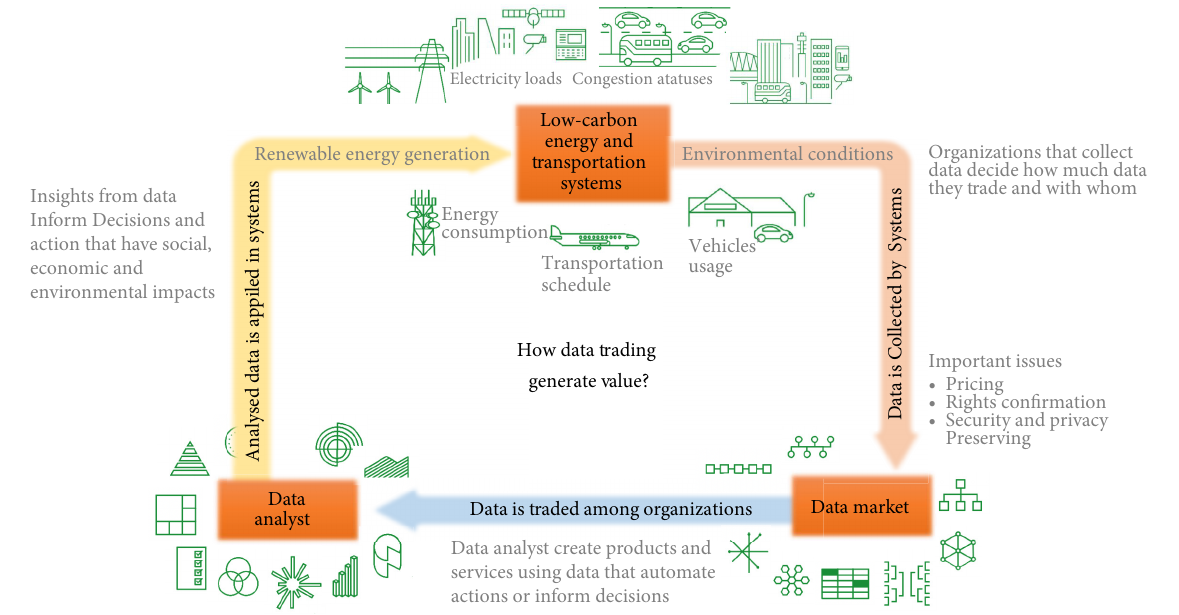
Fig. 1 How data trading could produce values in low-carbon and transportation